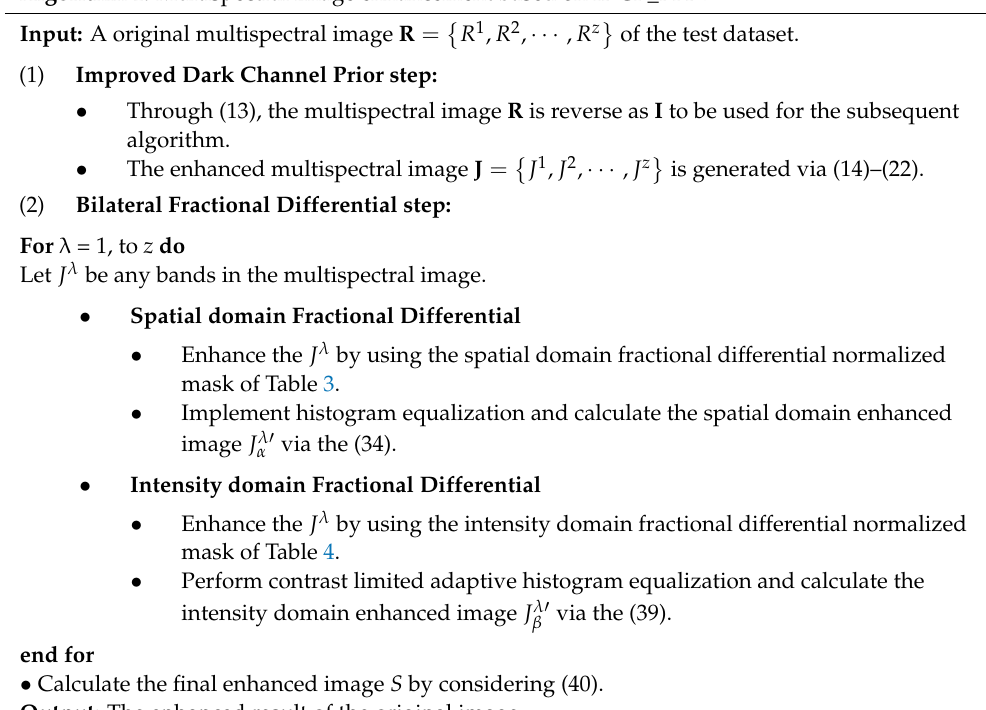
Algorithm 1. Multispectral image enhancement based on